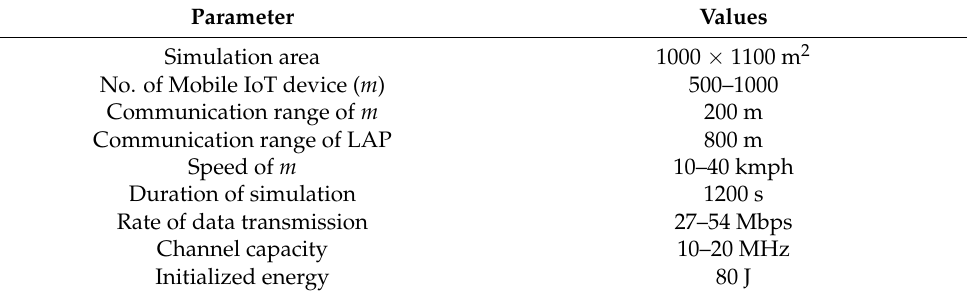
Table 1. Simulation parameter.